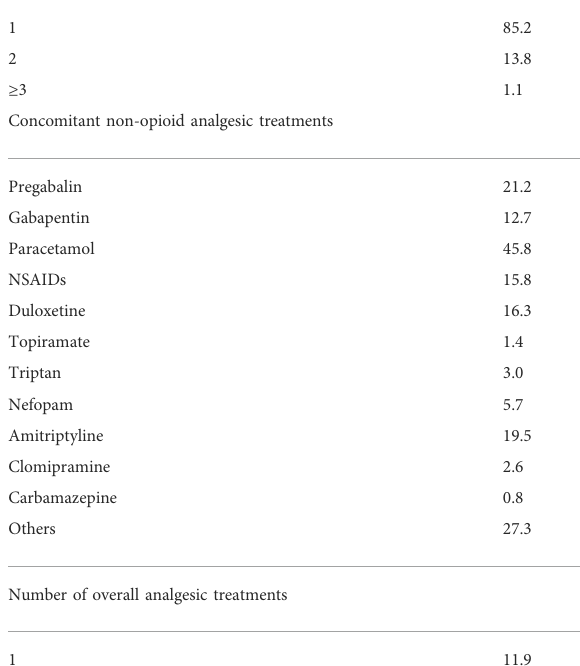
TABLE1Studypopulationcharacteristics.Dataofallincludedpatients ( n =951)arepresentedaspercentages,mean±standarddeviation or median (25th; 75th percentiles). * Dosage or frequency higher than prescribed.